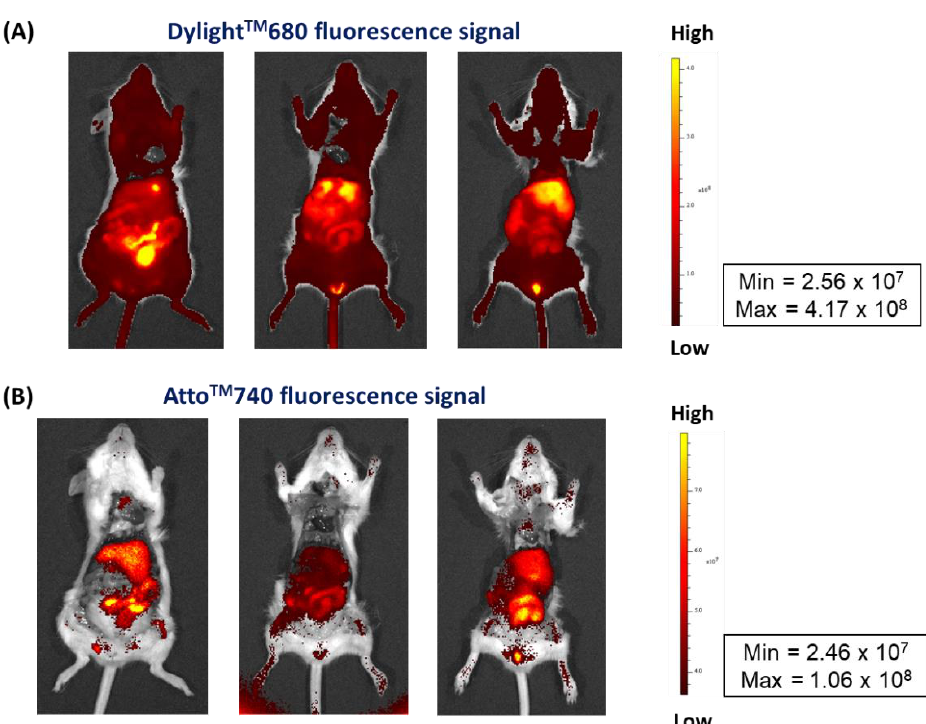
Figure 6. Ex vivo NIRF images of the optimized 111 In-radiolabeled and DTPA-derivatized NM-scFv made of control siRNA fluorescent-labeled with Atto TM 740 (DTPA/Fe molar ratio: 0.3) at 40 min after injection. ( A ) NV-scFv-DTPA signal, ( B ) siRNA signal.